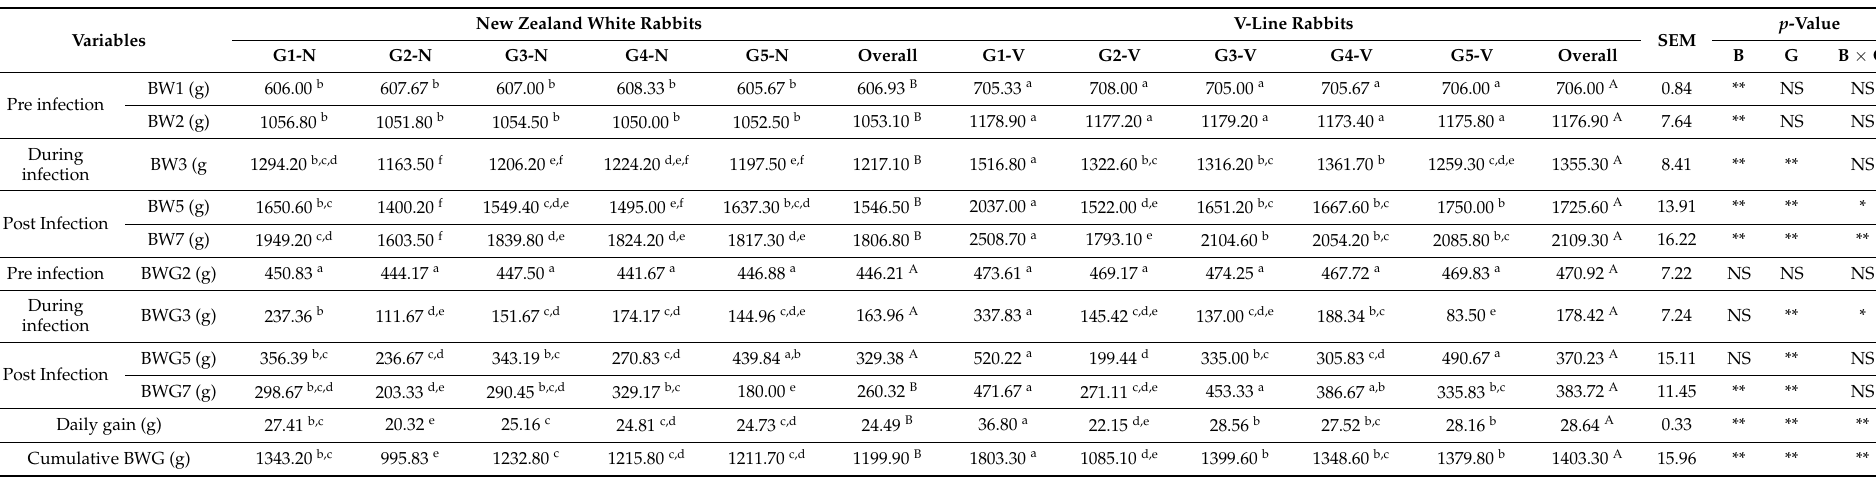
Table 1. Bodyweight changes of the New Zealand white and V-line rabbits in response to coccidial infection and herbal extract treatment.